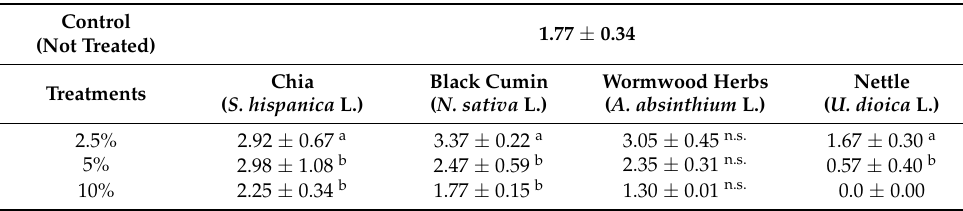
Table 13. Comparison of differences of means for radicle length of lettuce ( L. sativa L.) seedlings (The values in the table represent the mean value of radicle length in cm ±